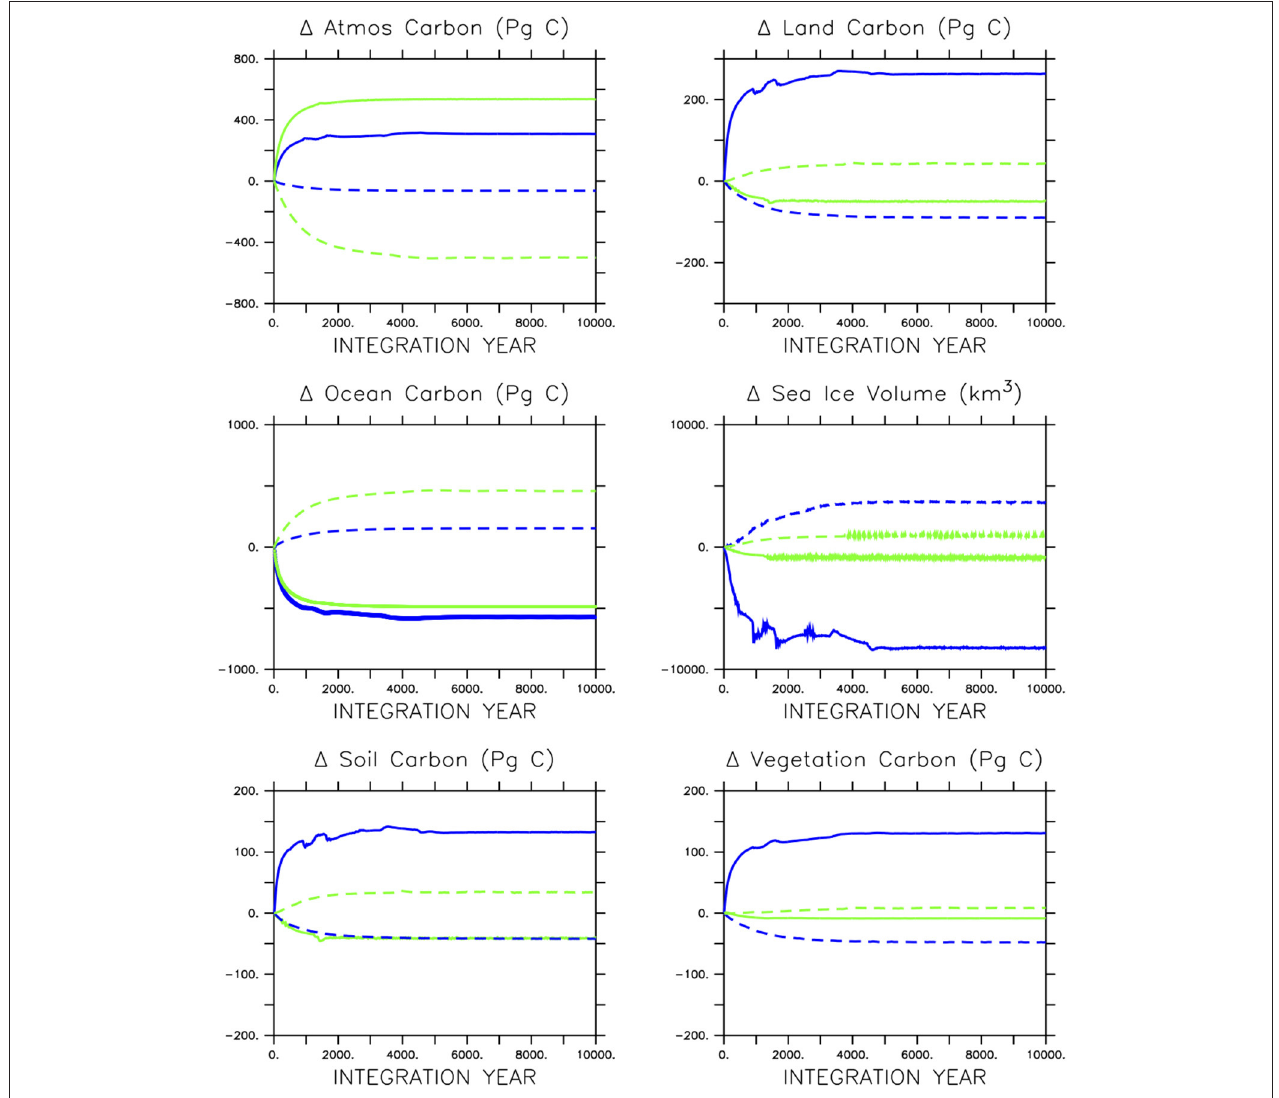
FIGURE 5 | Response of carbon partitioning and sea ice volume in icehouse (blue lines) and greenhouse (green lines) climates to stopping soft-tissue production and calcification (solid lines) or calcification only (dashed